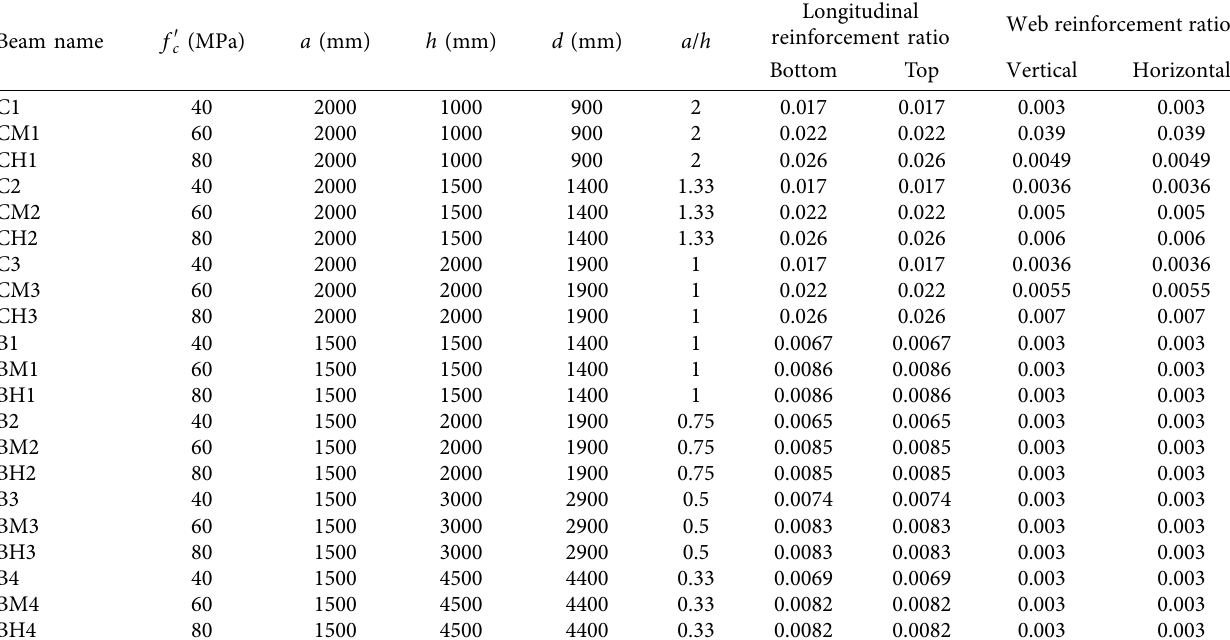
Table 5: Beams’ geometrical and reinforcement